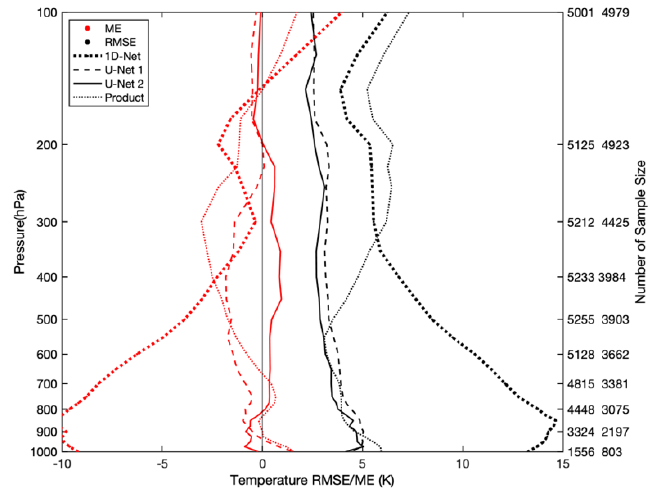
Figure 13. Same as Figure 12 except for all sky.